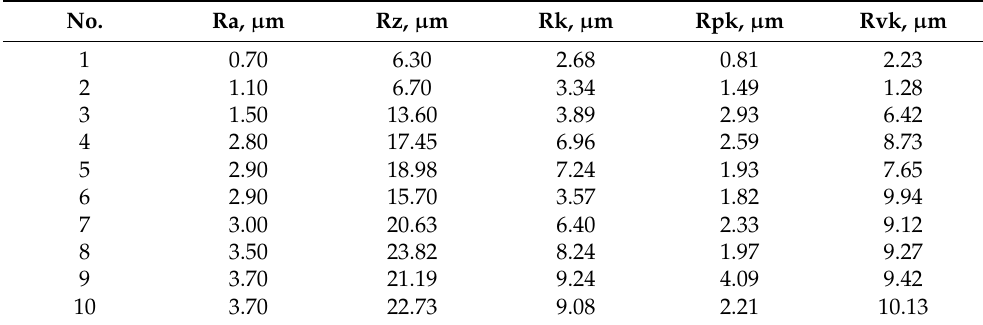
Table 3. The roughness parameters for composite coatings for surface after turning samples’ inserts according to the study program.